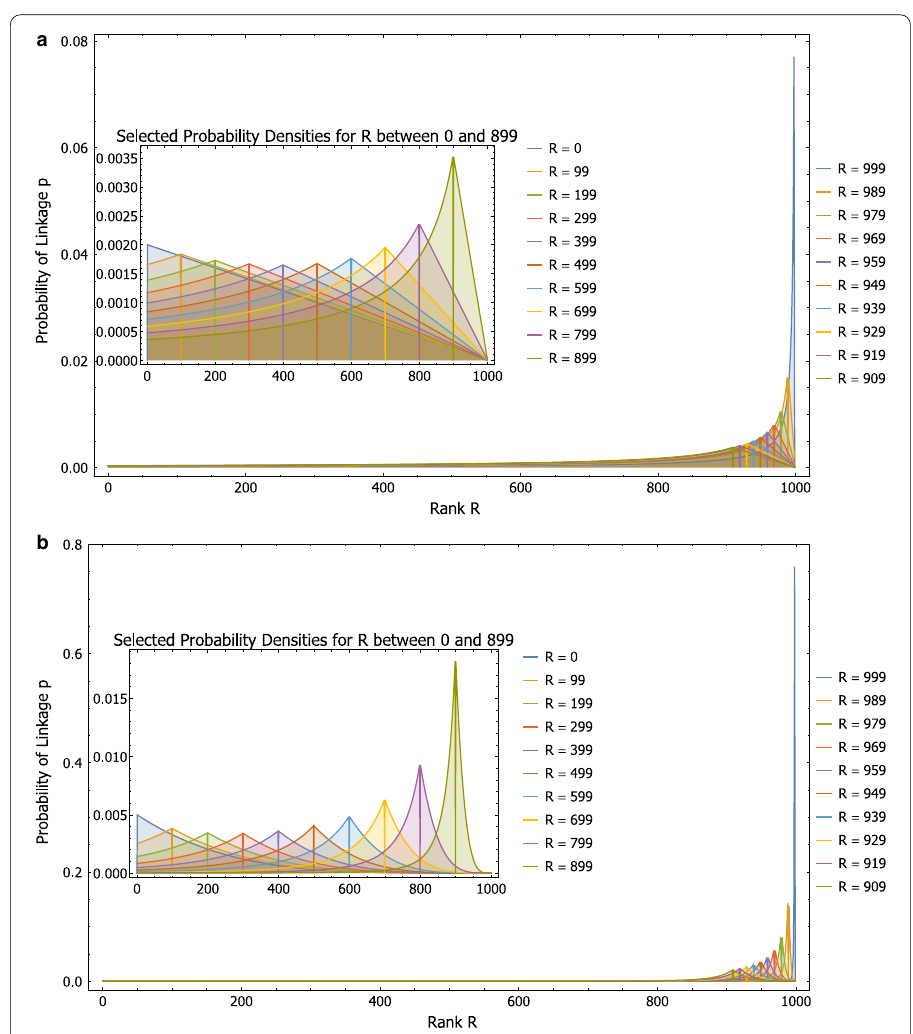
Fig. 2 Theoretical Probability Density Functions (PDFs) of a node with a given income rank R for linkage with another node for the whole support of income